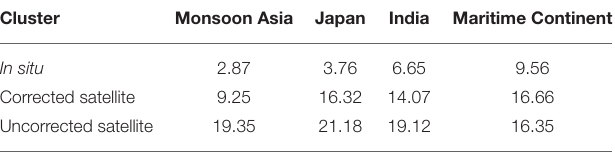
TABLE 2 | Coefficient of variation (cov) (in percentage (%); see section precipitation extremes) calculated over the 2001–2013 period for each product cluster: in situ , corrected satellite, and uncorrected satellite.